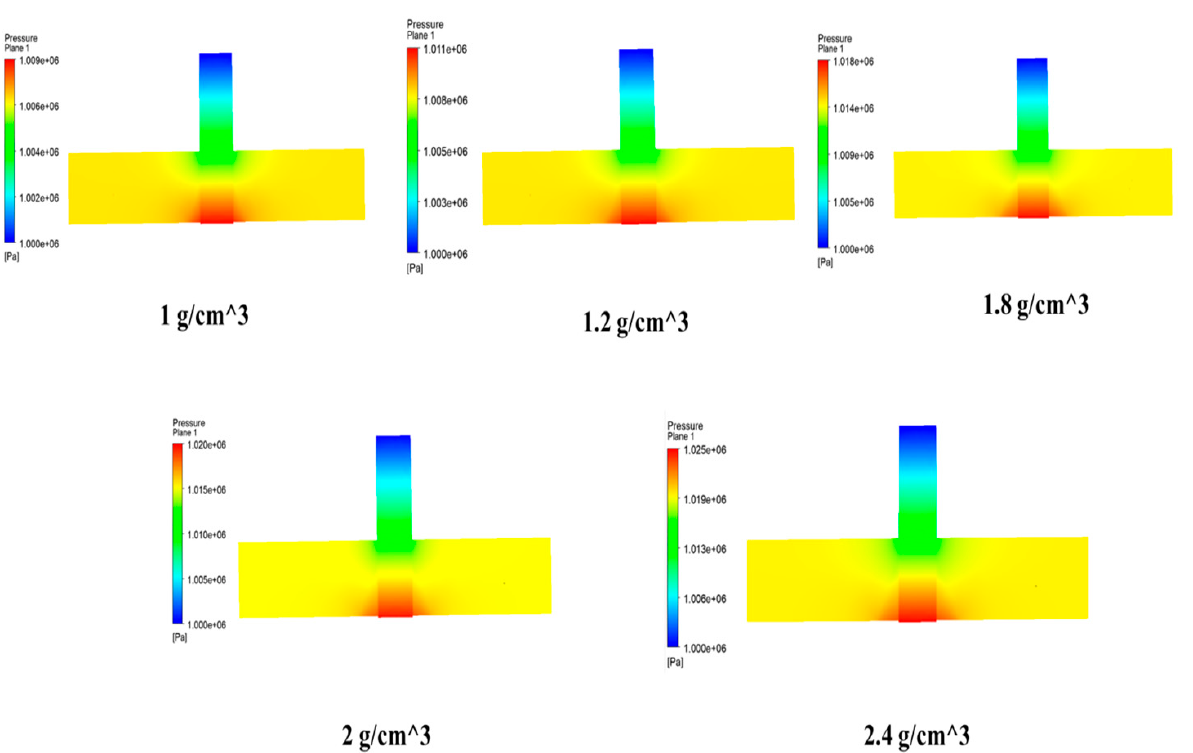
Figure 7. Gas invasion pressure distribution at different drilling fluid densities.